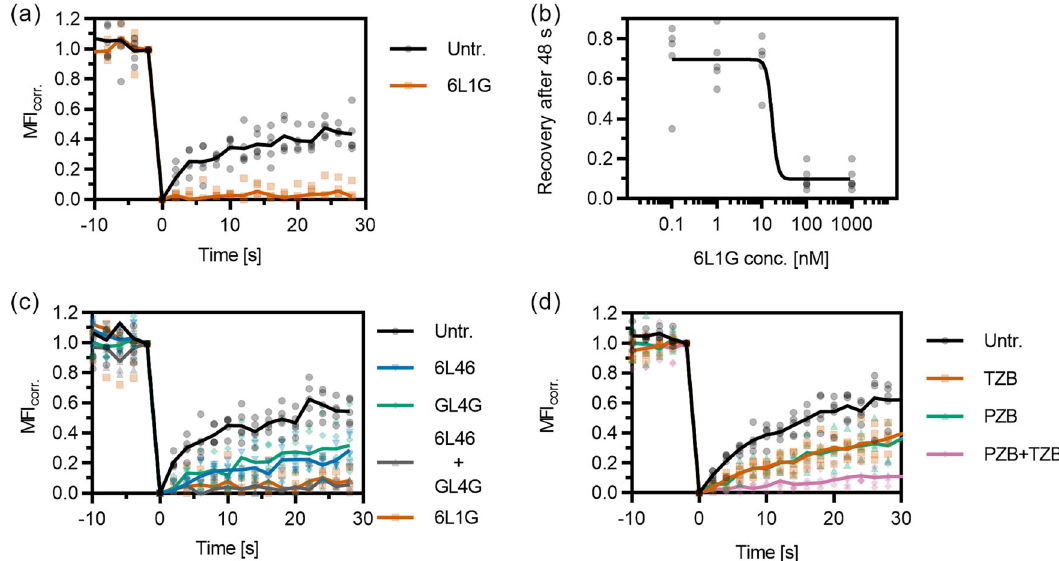
Fig. 4 Mobility changes of endogenous HER2 on the surface of BT-474 cells (labeled via the af fi body ZHER2) upon treatment with DARPins and mAbs as quanti fi ed by FRAP. a Dramatic loss of mobility upon treatment with bipDARPin 6L1G compared to untreated cells (Untr.). b Concentration dependence of the mobility reduction as illustrated by the relative fl uorescence recovery after 48 s. c Homo-bivalent, monoparatopic DARPins 6L46 and GL4G reduce HER2 mobility only slightly, while a mixture of both (GL4G + 6L46) fully immobilizes HER2 through crosslinking. d Similarly, moderate mobility changes are observed upon treatment with therapeutic mAbs PZB and TZB but almost complete immobilization by their combination (PZB +